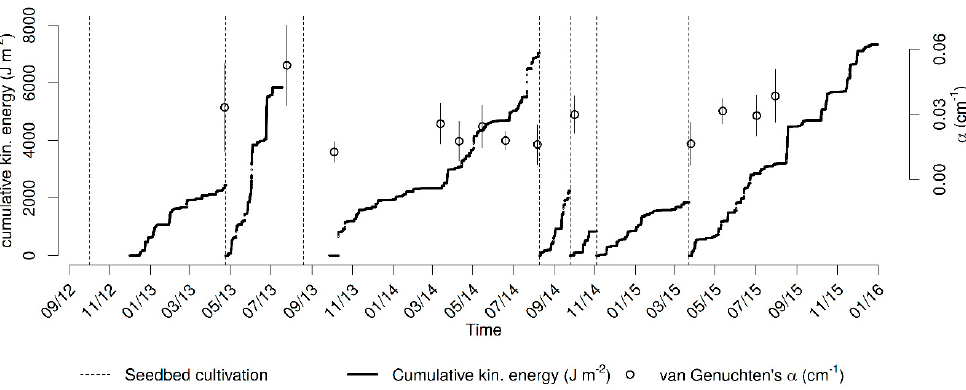
Figure 8. Seasonal variability of the van Genuchten’s parameter α related to cumulative rainfall kinetic energy. Seedbed cultivation (dashed line) is assumed to interrupt the effect of the previous rainfall.